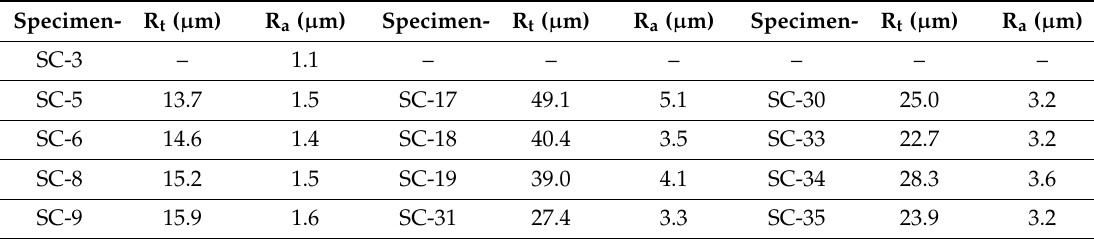
Figure 1. Specimen design and location of gauge and shoulder extensometers (dimensions in mm). Table 2. Surface roughness (ground